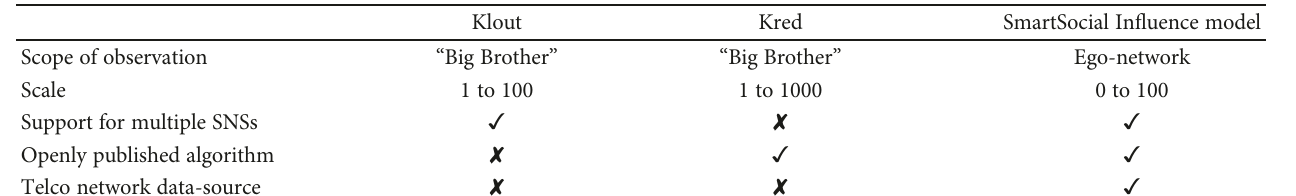
Table 1: Comparison of Klout, Kred, and the SmartSocial In fl uence.